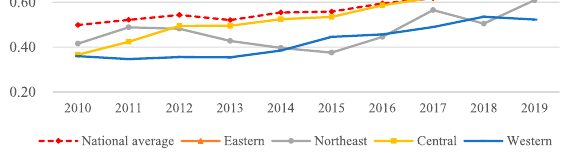
FIGURE 2 Changing trends of GIE in four regions of